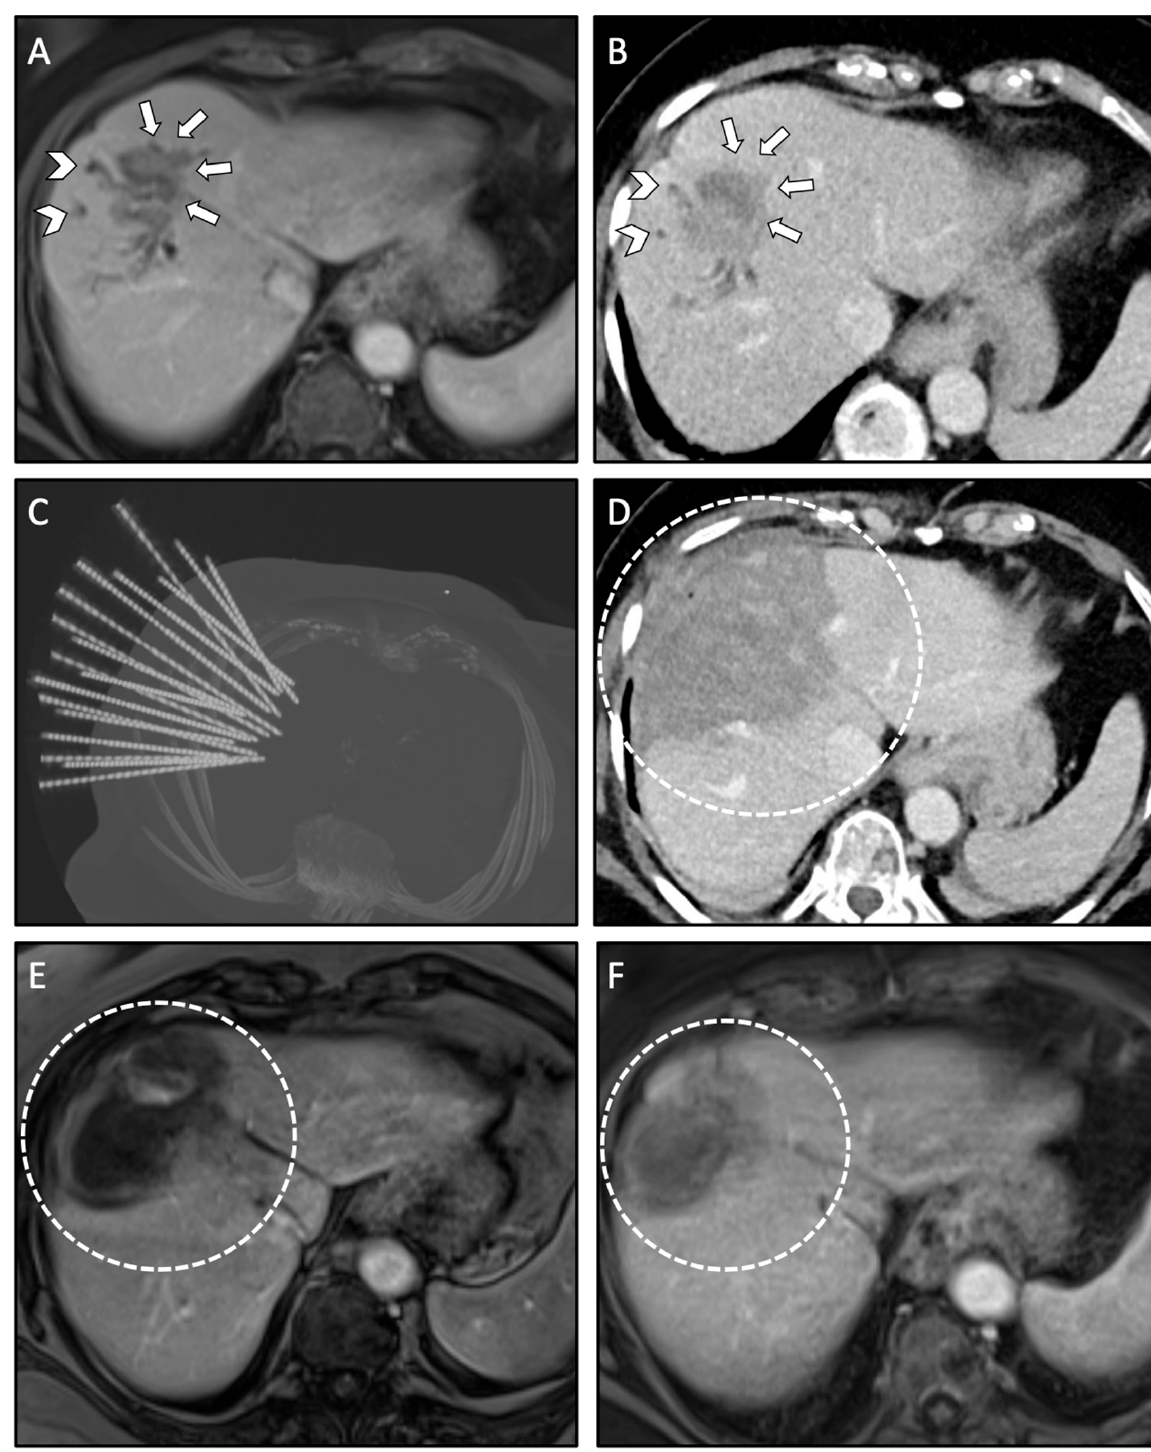
Figure 2. Case of a 76-year-old female with local recurrence of CRLM after conventional US- guided RFA treated by anatomical ablation of liver segment VIII using 18 coaxial needles for SRFA. ( A , B ) Pre-interventional MRI scan ( A ) and planning CT scan ( B ) of the SRFA procedure with 45 mm recurrence of the CRLM (white arrows) and consecutive dilated intrahepatic bile ducts in liver segment VIII indicating cholestasis (white arrowhead). ( C ) Maximum Intensity Projection (MIP) of the non-enhanced control CT scan showing the position of 18 coaxial needles. ( D ) Final control CT scan after anatomical ablation with complete necrosis of liver segment VIII. ( E , F ) Follow-up MRI scan at 3 months ( E ) and 21 months ( F ) after SRFA, showing no evidence of LTP with shrinking necrosis zones (white dashed circle).